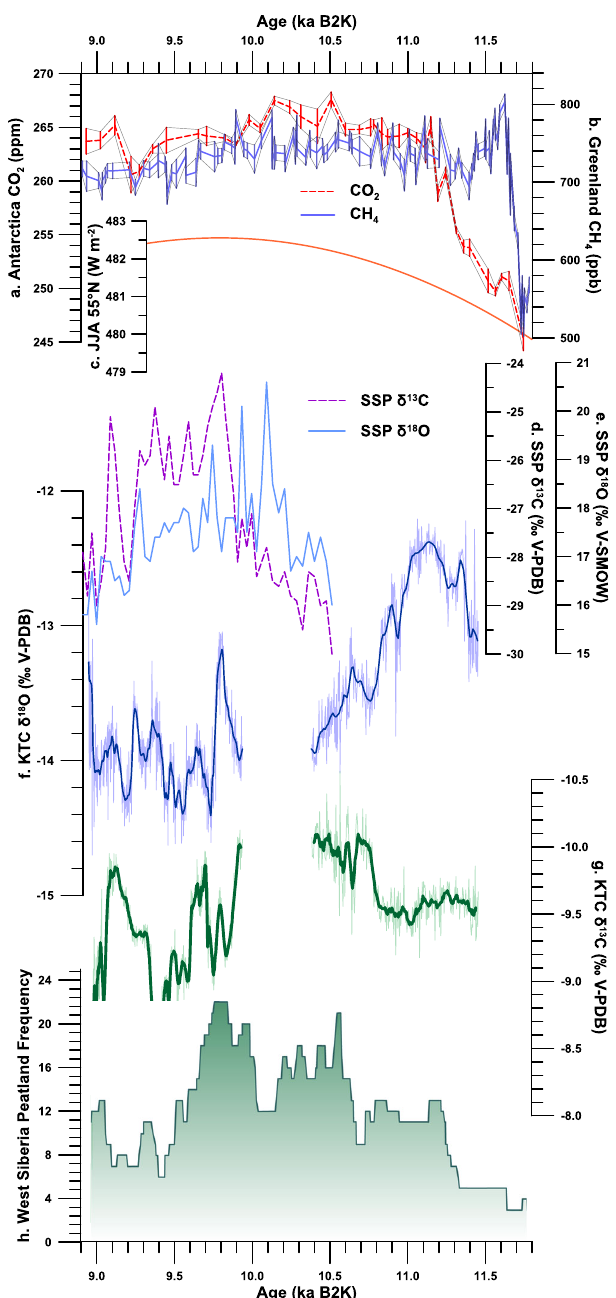
Fig. 4 Climatic and permafrost response in West Siberia to Early Holocene forcings. Comparison of stalagmite K4 with regional proxy records and forcings. High-resolution composites of a atmospheric CO 2 in Antarctic ice cores 38 (dashed red); and b atmospheric CH 4 in Greenland ice cores 39 (solid blue). Error bars denote the reported 2- σ analytical uncertainty. c Summer (JJA) insolation at 55 o N. Sahara Sand Peatland record of cellulose d δ 13 C, a proxy for summer T 17 (dashed purple); and e δ 18 O, a proxy for winter T 33 (solid light blue). f K4 δ 18 O (light blue; this study) with 15-point LOESS smoothing (bold line). g K4 δ 13 C (light green; this study) with 15-point LOESS smoothing (bold line). h Frequency of basal peat core ages in West Siberia 42 . The geographical locations of proxy records are shown in Fig. 1, excepting the Antarctic ice